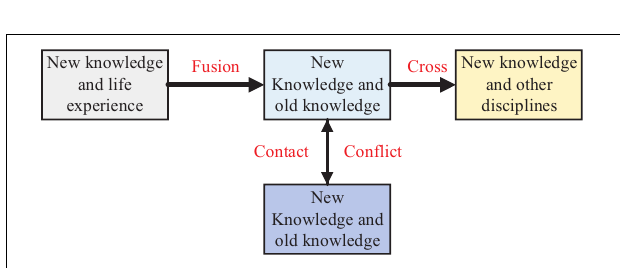
FIGURE 2 | Structural diagram of the construction of the connection between new and old knowledge under the orientation of deep